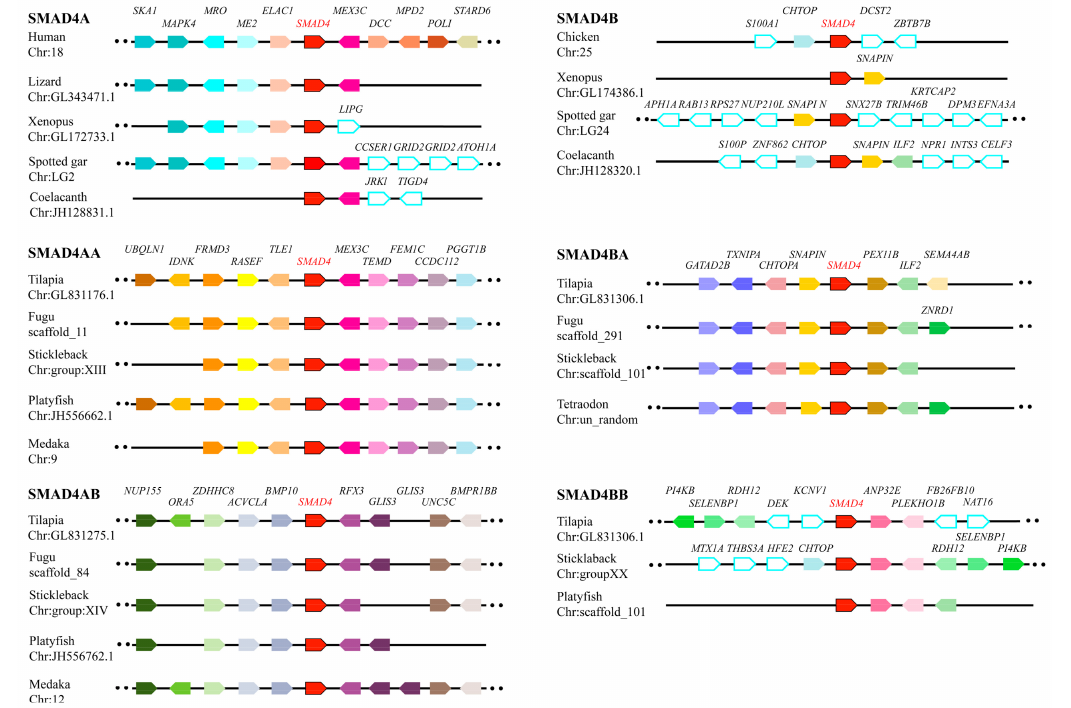
Figure 5. Syntenic analysis of SMAD4 genomic region. Genomic regions flanking SMAD4 copies were analyzed in representative vertebrate species including tetrapods (human, chicken, lizard, and xenopus), sarcopterygians (coelacanth) and actinopterygians (spotted gar, tilapia, fugu, stickleback, medaka, platyfish, and tetraodon) using Genomicus browser. The chromosome or scaffold number was indicated under the species name. The bar lengths were not proportional to the distances between genes. Dotted lines indicated omitted genes in the chromosome or scaffold. Different genes were represented by different colored pentagons and SMAD4 copies were indicated in red. The direction of pentagons indicated the gene direction. The gene names were placed on top of the